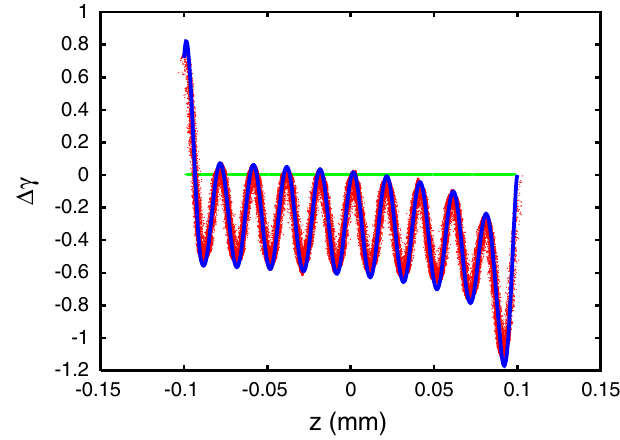
FIG. 4. (Color) Longitudinal phase-space distribution after a bending magnet for an initial sinusoidal density modulation. Numerical result (red), analytical prediction (blue), and the initial distribution (green) are